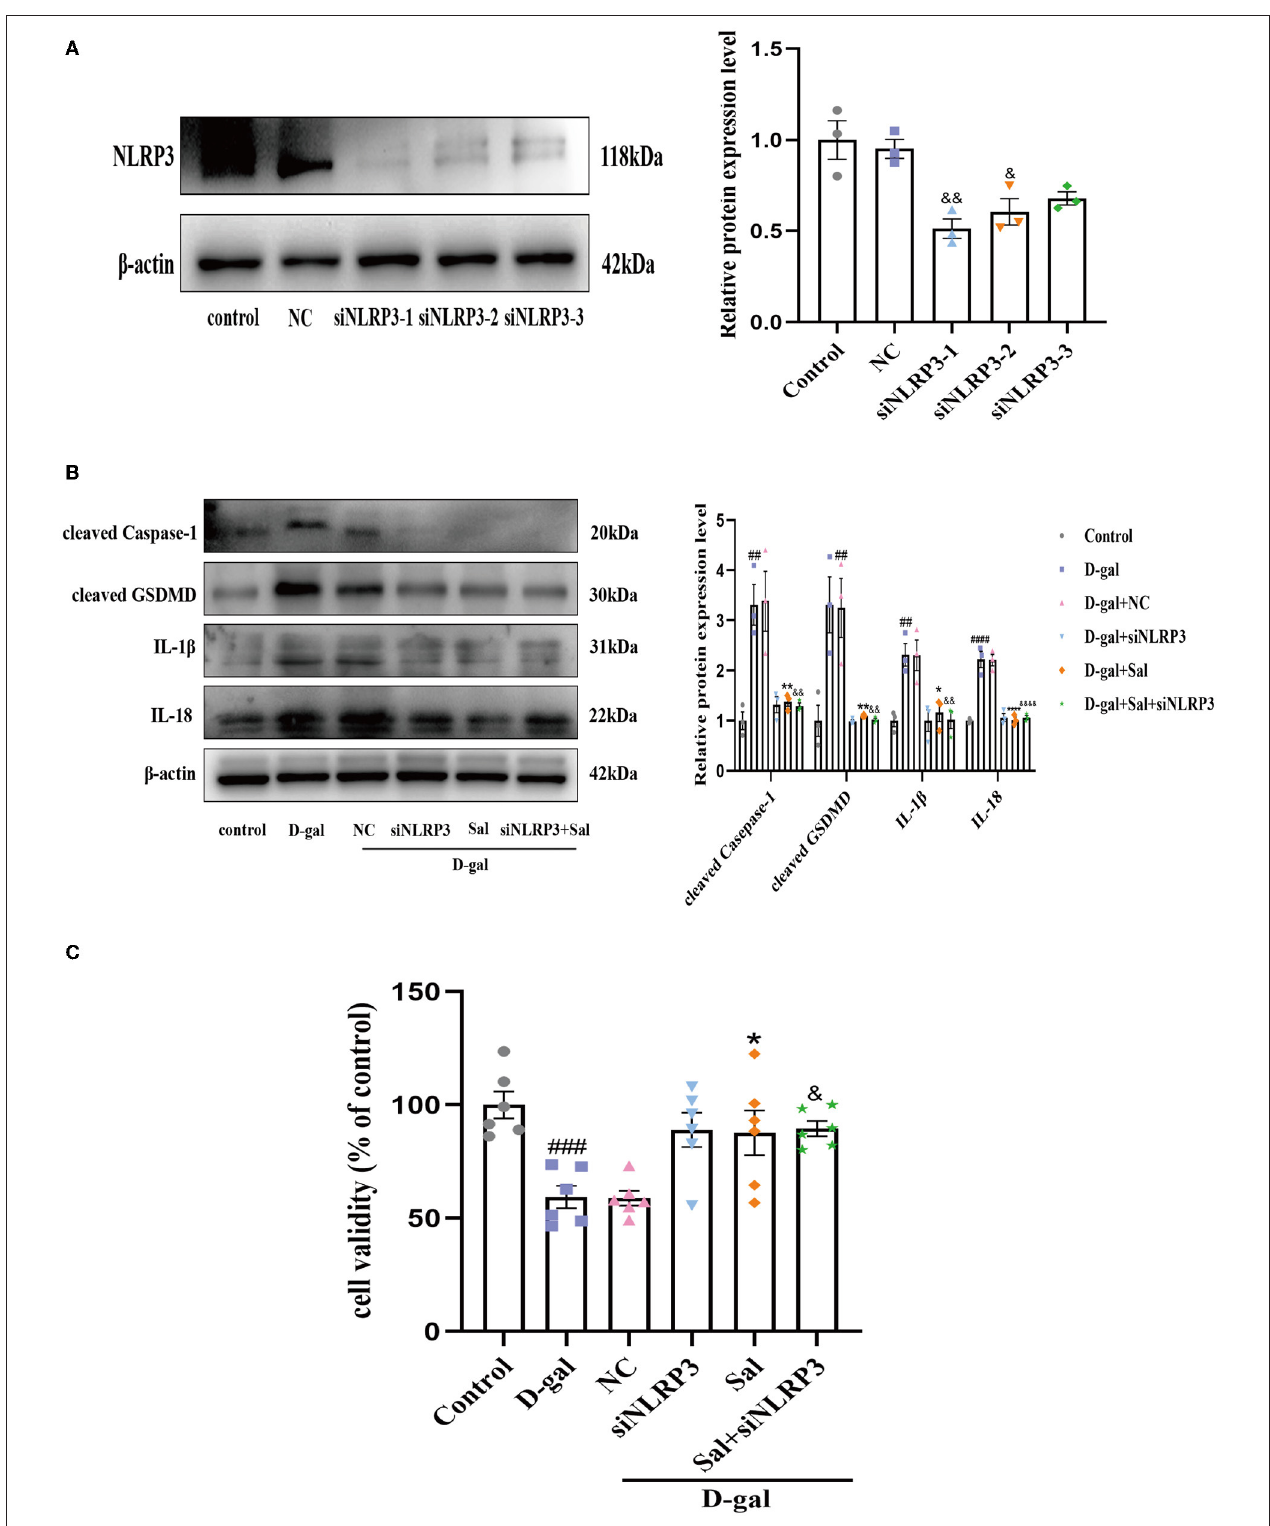
FIGURE 10 | Sal inhibited pyroptosis through NLRP3 inflamasome. (A) Western blot validated the effect of NLRP3 knockout, β -actin was used as an internal control ( n = 3). (B) The Western blot analysis of cleaved Caspase-1, cleaved GSDMD, IL-1 β , and IL-18 of PC12 cells, β -actin was used as an internal control ( n = 3). (C) CCK-8 measured the cytotoxic effects of Sal or siNLRP3 on PC12 cells ( n = 6). ## P < 0.01, ### P < 0.001, #### P < 0.0001 vs. control group, * P < 0.05, ** P < 0.01 vs. D-gal group. & P < 0.05, && P < 0.01, &&&& P < 0.0001 vs. NC group.